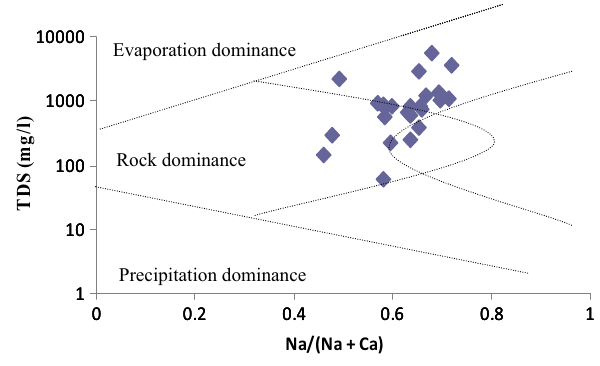
Fig. 3 Gibb’s diagram for the factors regulating groundwater